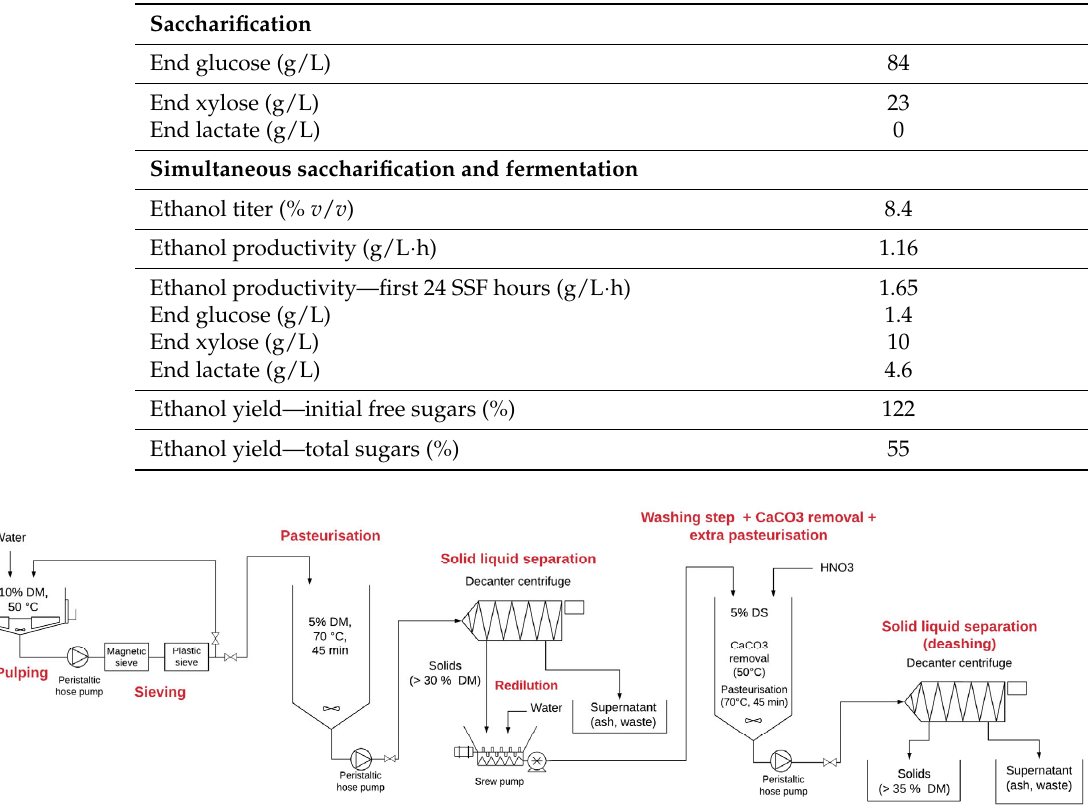
Table 4. SSF process results (2 m 3 scale), demonstrated on pretreated cardboard and paper waste.